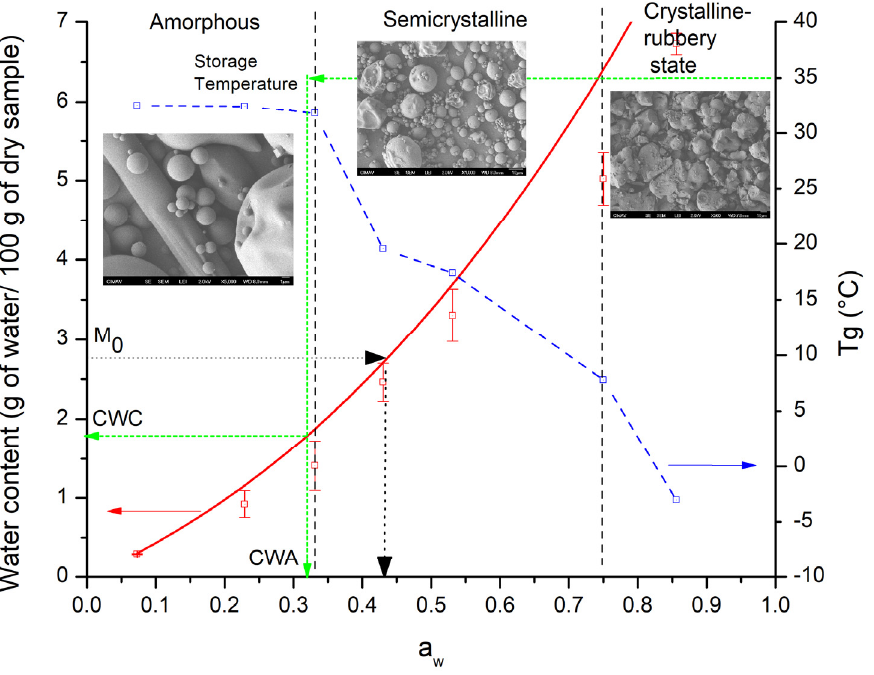
Figure 7. Equilibrium state diagram at 35 °C of functional food blend MX-IN:25-75. The Tg (blue dashed curve) shows a tendency to decrease with moisture adsorption.